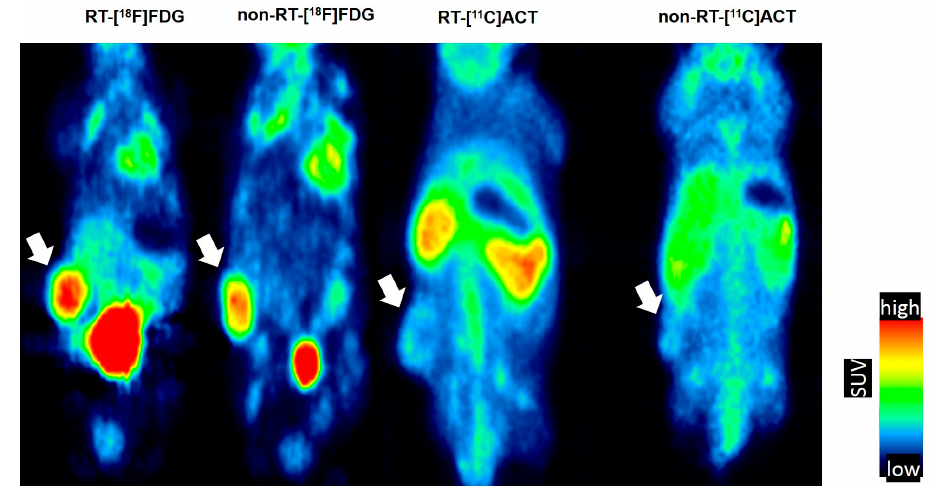
Figure 2. Coronal view of a representative [ 18 F]FDG and [ 11 C]Acetate ([ 11 C]ACT) PET scans in non-RT mouse and Day 3-RT mouse. The relative lower tumor uptake in [ 11 C]ACT PET. Tumors are indicated by white arrows.